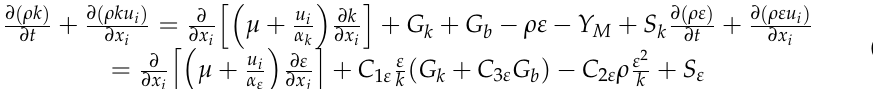
Figure 2. Meshed water and fertilizer mixing pipe model.